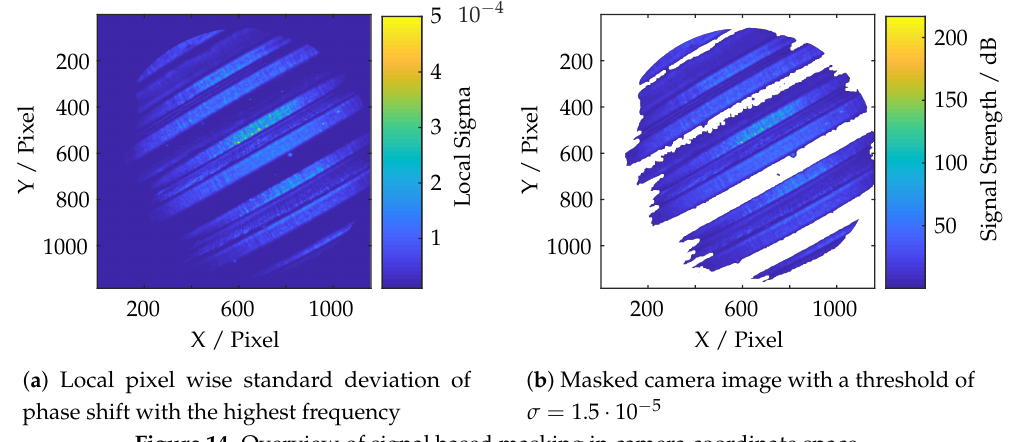
Figure 14. Overview of signal based masking in camera coordinate